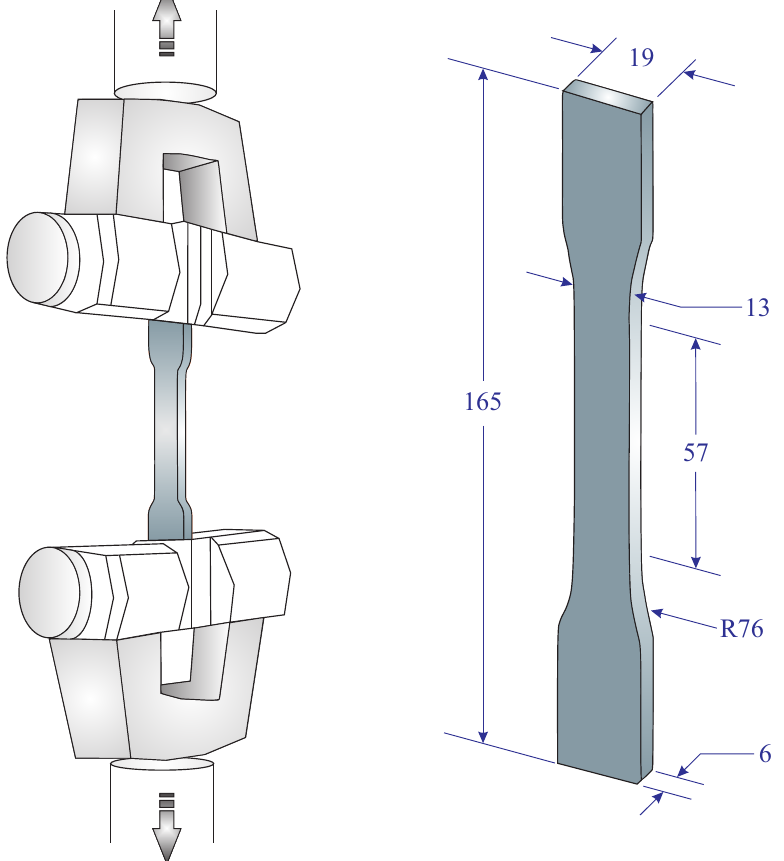
Figure 2. Geometries of a dumbbell-shaped specimen and schematic of tensile test conditions (dimensions in